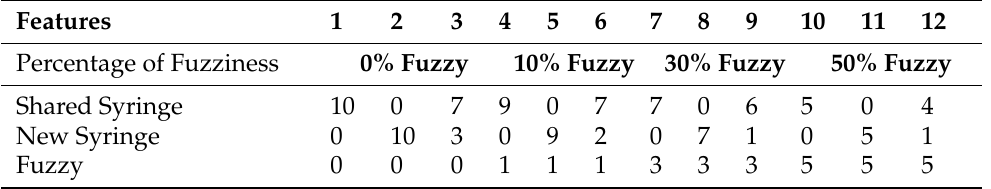
Table 3. Data of the twelve examples for four different